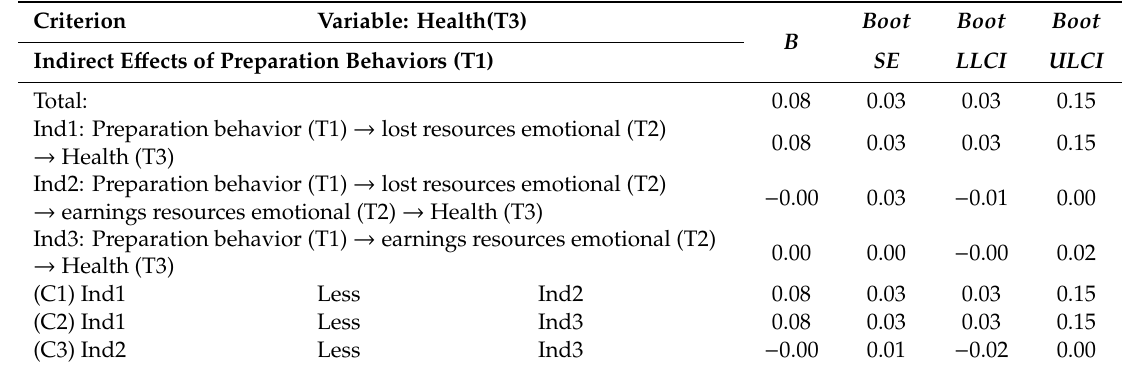
Table 13. Comparison of the indirect e ff ects of preparation behaviors (T1) through the losses (T2) and gains of emotional resources (T2) in the prediction of health